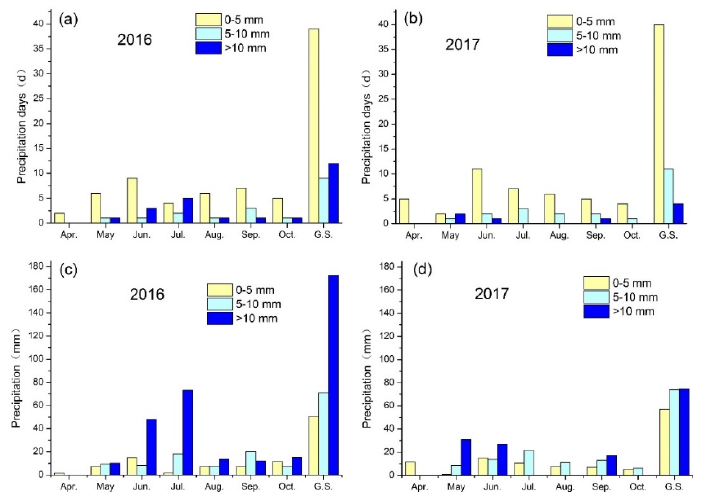
Figure 4. Number of precipitation days and amounts of precipitation (at different levels) in different precipitation years. ( a ) Monthly precipitation days during growing season in 2016; ( b ) monthly precipitation days during growing season in 2017; ( c ) amount of monthly precipitation during growing season in 2016; and, ( d ) amount of monthly precipitation during growing season in 2017. G.S. is the abbreviation for growing